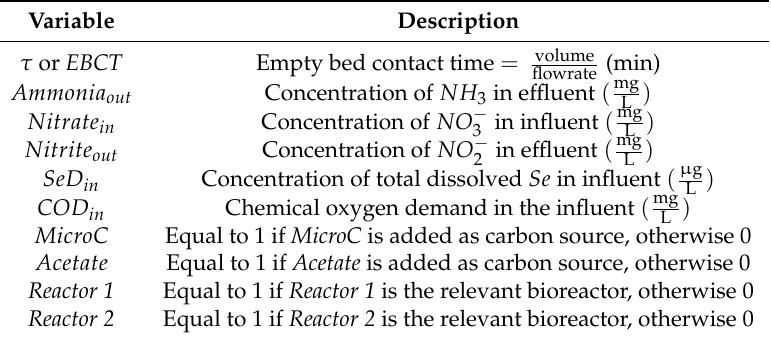
Table 1. Water chemistry variables.